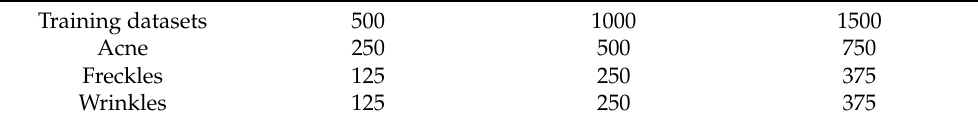
Table 5. Distribution of symptom training datasets.